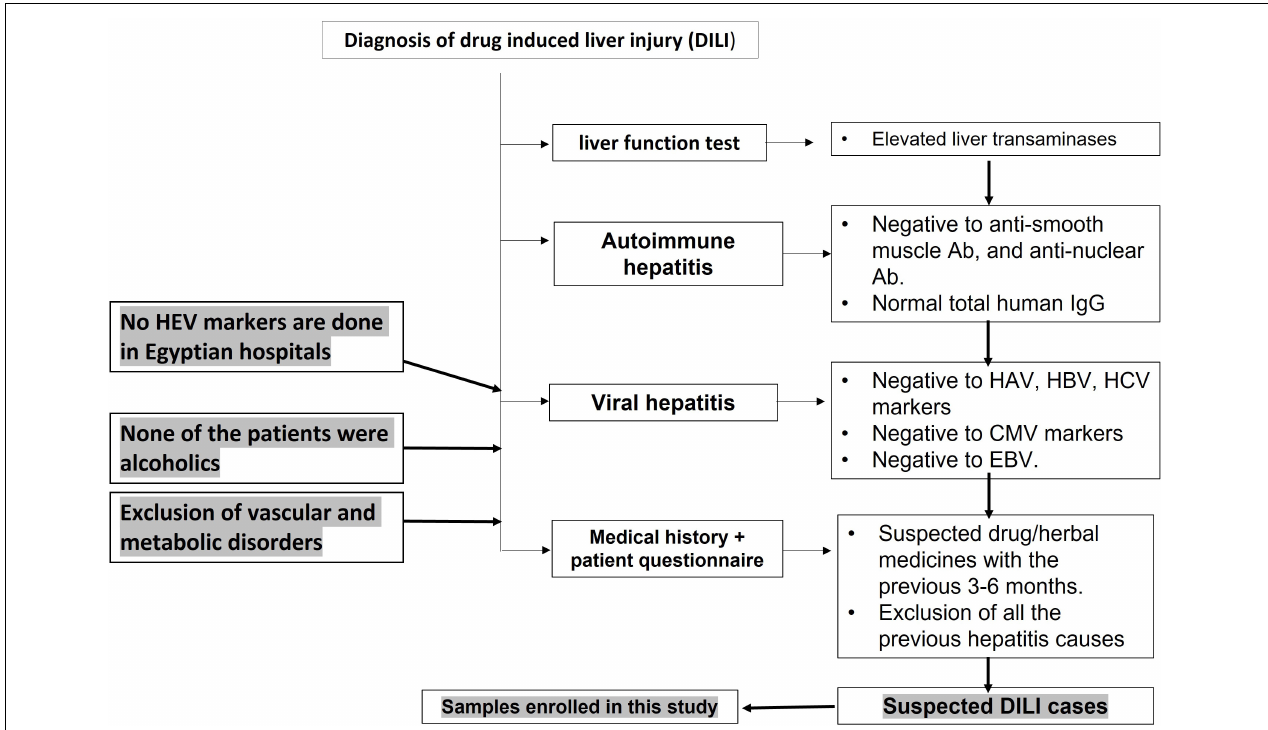
FIGURE 1 | Flow chart showing the diagnosis of drug-induced liver injury in Egyptian hospitals. Acute hepatitis cases were assessed for liver function tests (LFTs), including liver transaminases and bilirubin. Patients with abnormal LFTs were screened for autoimmune hepatitis markers and viral hepatitis